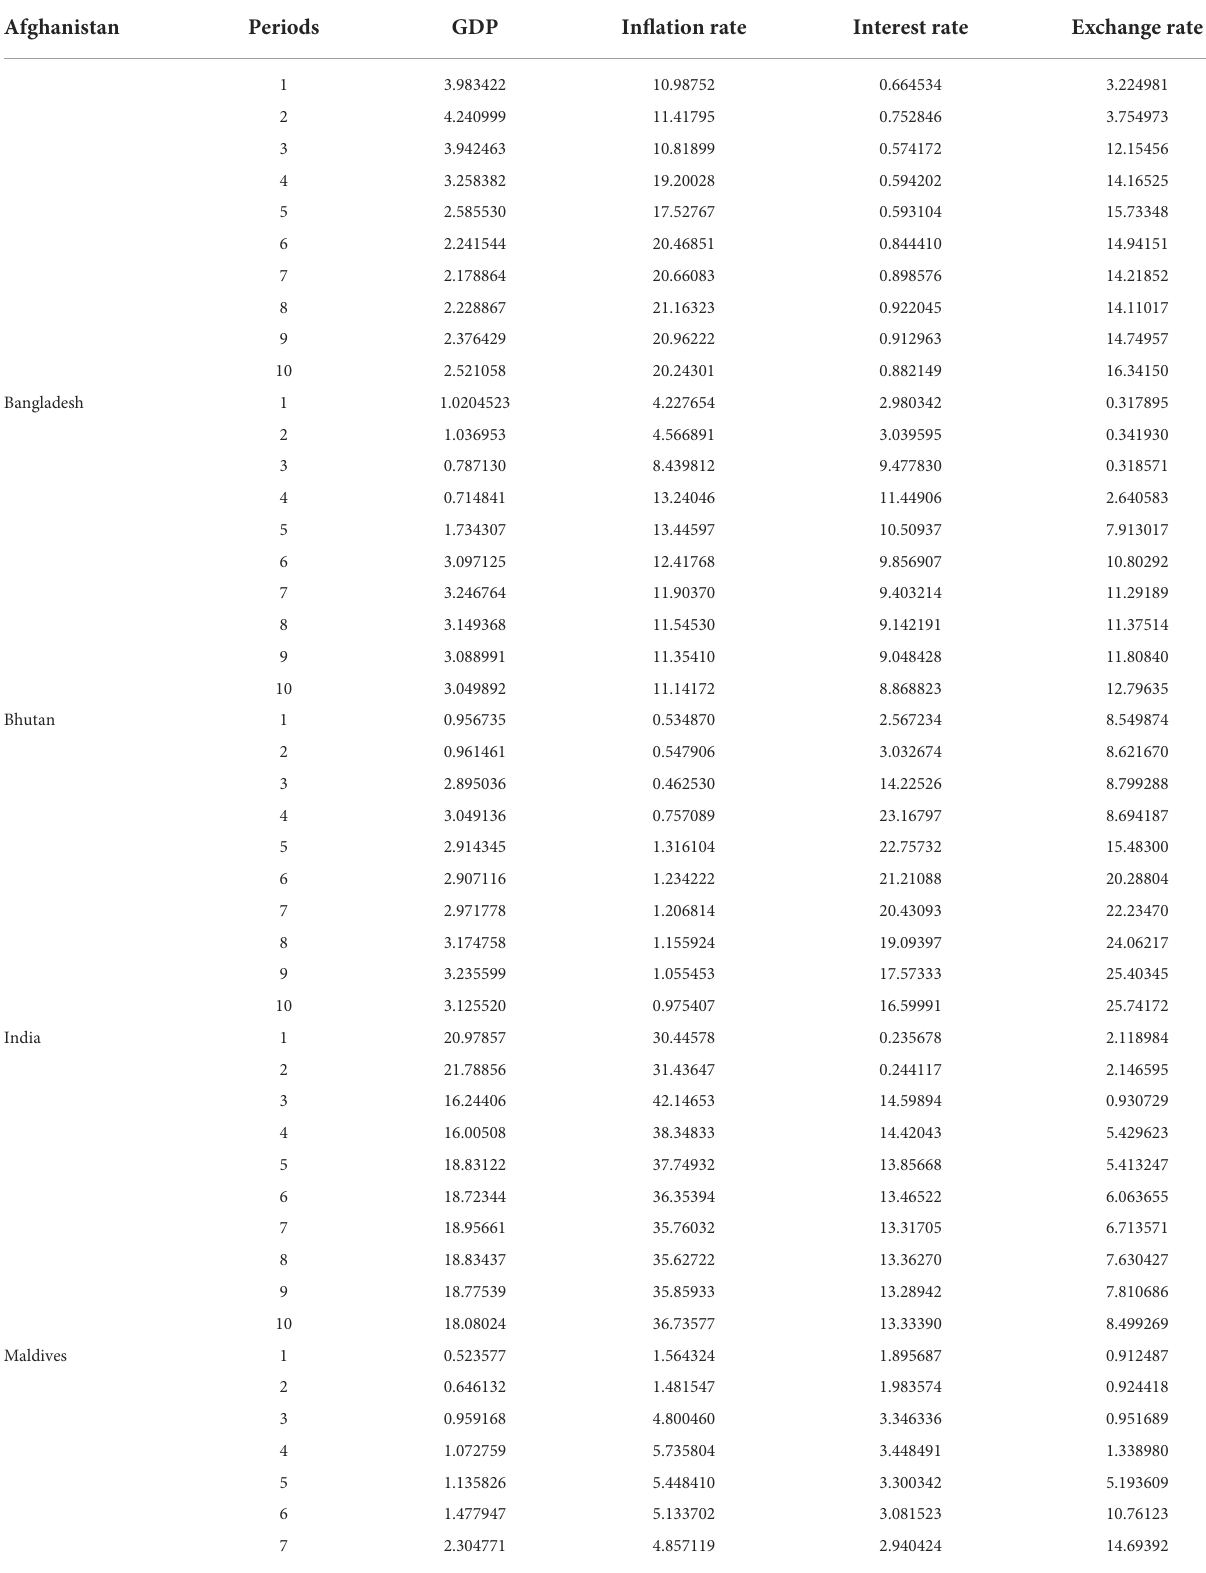
TABLE 4 Variance decomposition of crude oil price.